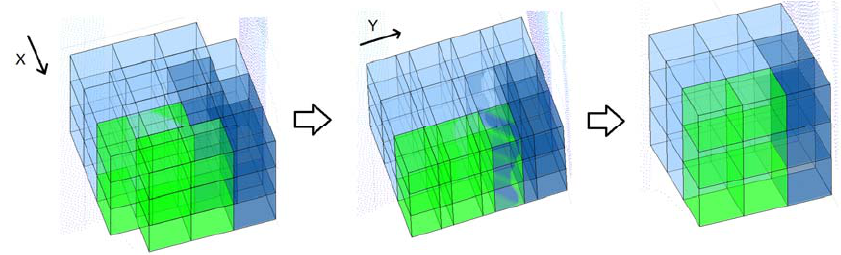
Figure 15. XY-translation to make the current voxelization coincide with the previous one. Light blue: empty voxel; dark blue: occupied voxel; green: door voxel.